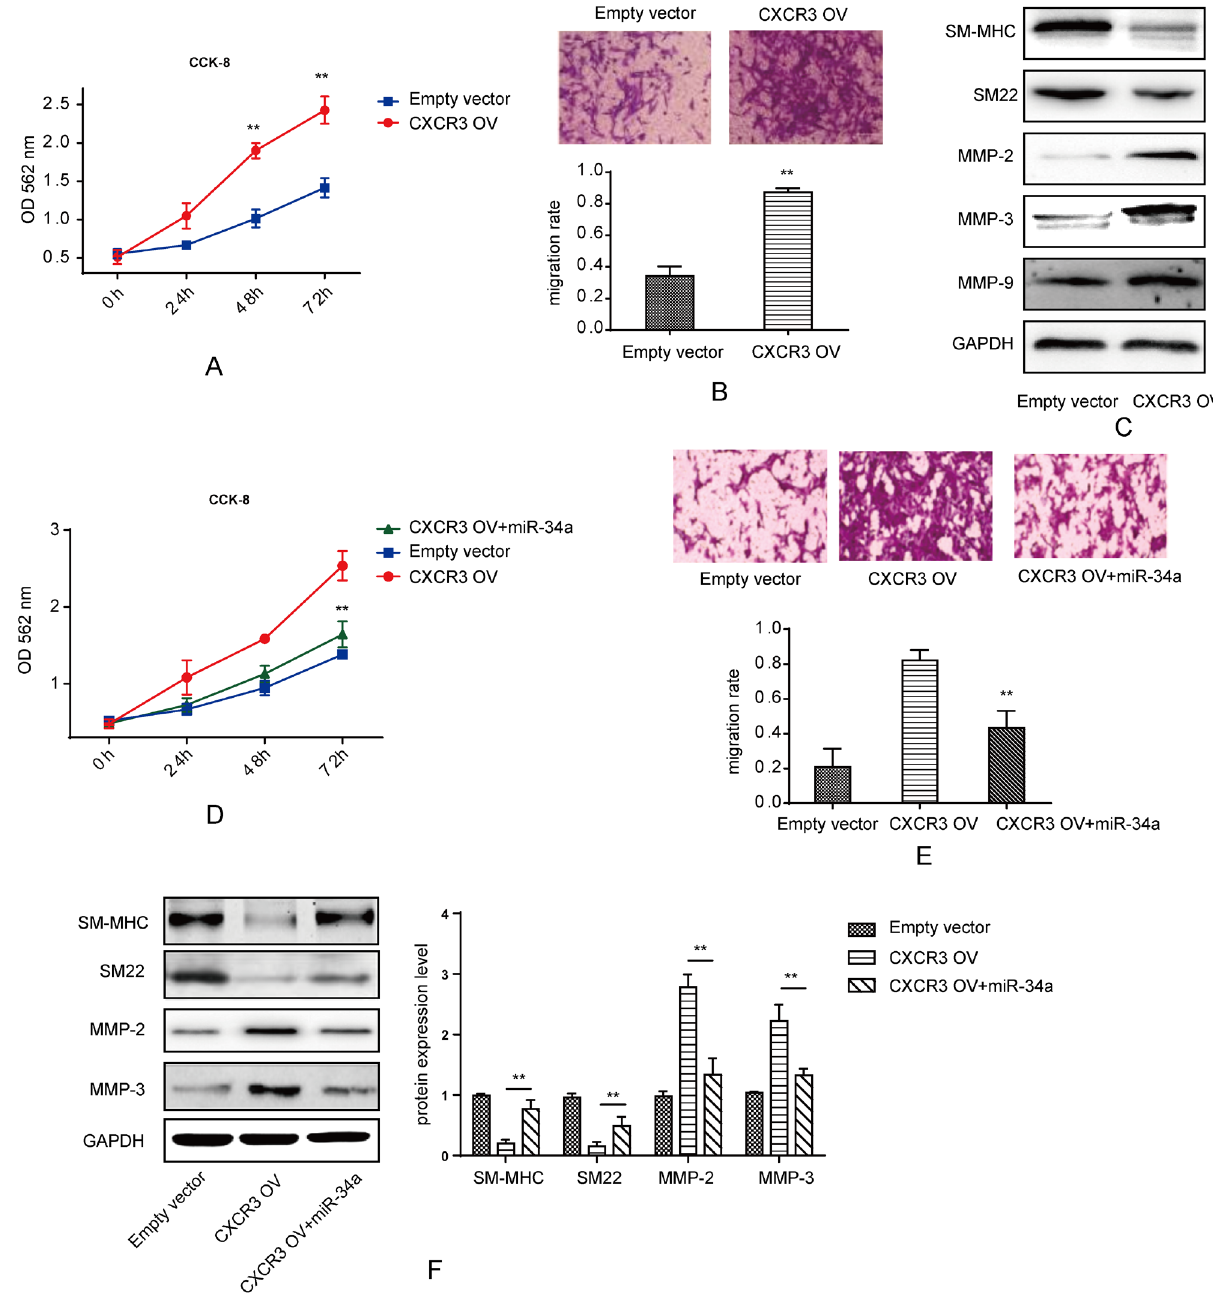
Figure 5 – The effect of CXCR3 on cell proliferation and contractile proteins expression. (A) CCK-8 kit was used to detect proliferation of VSMCs when transfected with CXCR3 OV and empty vector, CXCR3 overexpression induced proliferation compared to empty vector group, **p < 0.01. (B) Transwell assay was used to detect migration ability of smooth muscle cells when treated with CXCR3 OV and empty vector, quantification was calculated based on OD value in each group and normalized to empty vector group, *p < 0.05, **p < 0.01. (C) Western blot was used to test SM-MHC, SM22, MMP- 2, MMP-3 and MMP-9 protein level when transfected with CXCR3 OV and empty vector in smooth muscle cells. (D) CCK-8 kit was used to detect proliferation of VSMCs when transfected with CXCR3 OV and empty vector or co-transfected with miR-34a mimics, co-transfection of miR-34a and CXCR3 OV reversed the proliferation rate of VSMCs compared to CXCR3 OV group, **p < 0.01. (E) Transwell assay was used to detect migration ability of smooth muscle cells when treated with CXCR3 OV and empty vector or co-transfected with miR-34a, quantification was calculated based on OD value in each group and normalized to empty vector group, co-transfection of miR-34a and CXCR3 OV reversed the migration rate of VSMCs compared to CXCR3 OV group **p < 0.01. (F) Western blot was used to test SM-MHC, SM22, MMP-2, MMP-3 protein level when transfected with CXCR3 OV and empty vector or co-transfected with miR-34a mimics in smooth muscle cells, quantification was calculated based on light density of bands in Quantity One, **p <